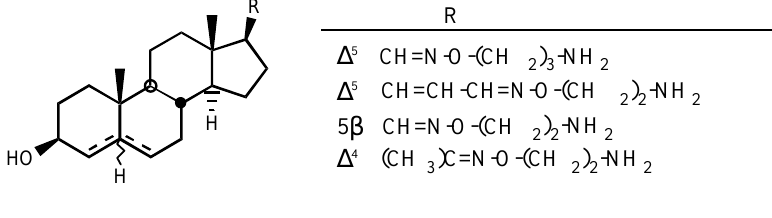
Figure 22. Structure of some C/D trans